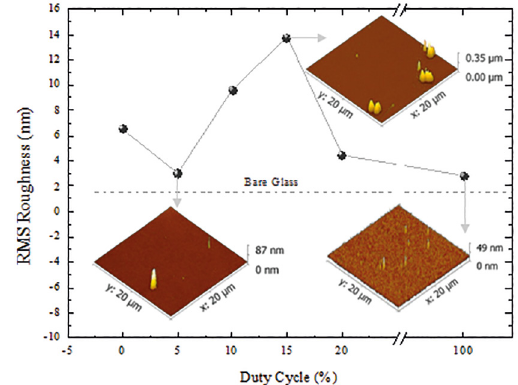
Figure 9. RMS roughness of the films as function of the duty cycle of the bias signal. The dotted line represents the roughness for the bare glass substrate. The inserts represent 3D topographic profiles of the corresponding samples. of the duty cycle of the pulses. The dotted line in this figure represents the roughness of the bare glass